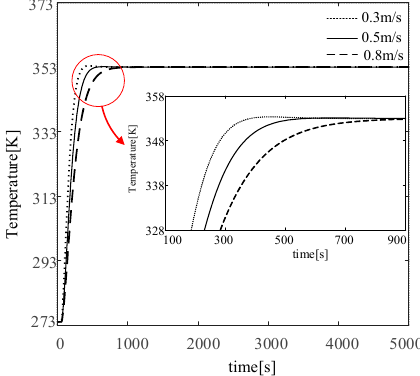
Figure 8. Temperature curves with different flow rates.